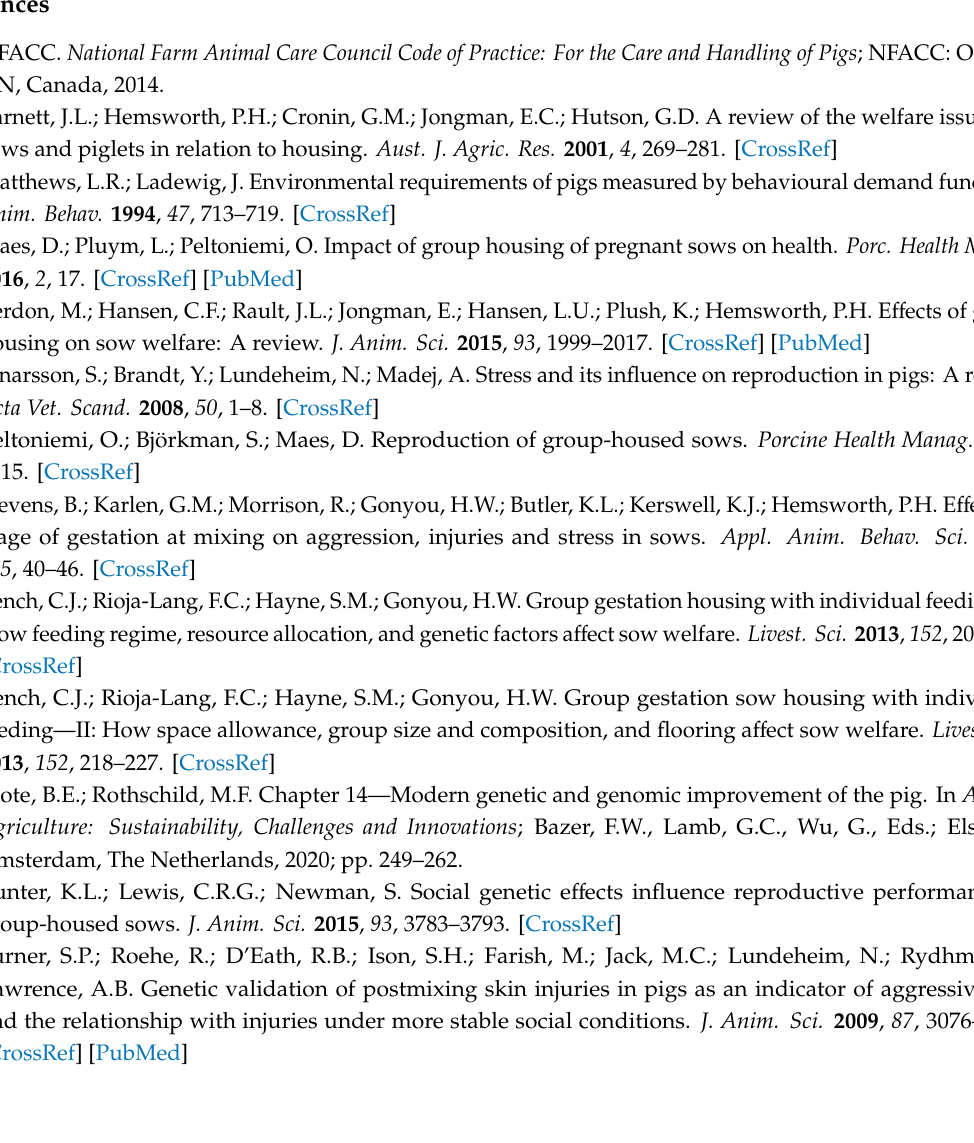
Table S1: Summary of the information related to